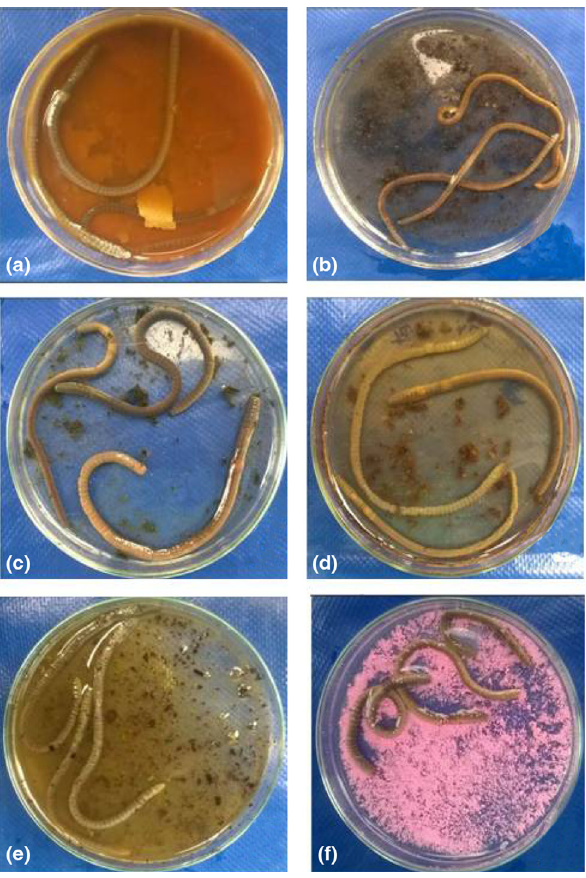
Figure 3: Anthelmintic activity of D. viscosa : ( a ) physiology of P. posthuma treated upon aqueous extract of D. viscosa ; ( b ) treat - ment of ethanolic extract of D. viscosa ; ( c ) treatment of methanolic extract of D. viscosa ; ( d ) treatment of chloroform extract of D. viscosa ; ( e ) treatment upon petro benzene extract of D. viscosa ; and ( f ) albendazole drug shows the entire physiology of P. posthuma .